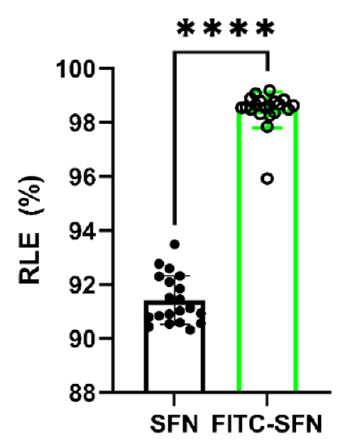
Figure 1. Radiolabeling efficiency (RLE) of the SFN and FITC-SFN measured in the optimized con- ditions. Unpaired t-test: ****, p < 0.0001; (n = 20).